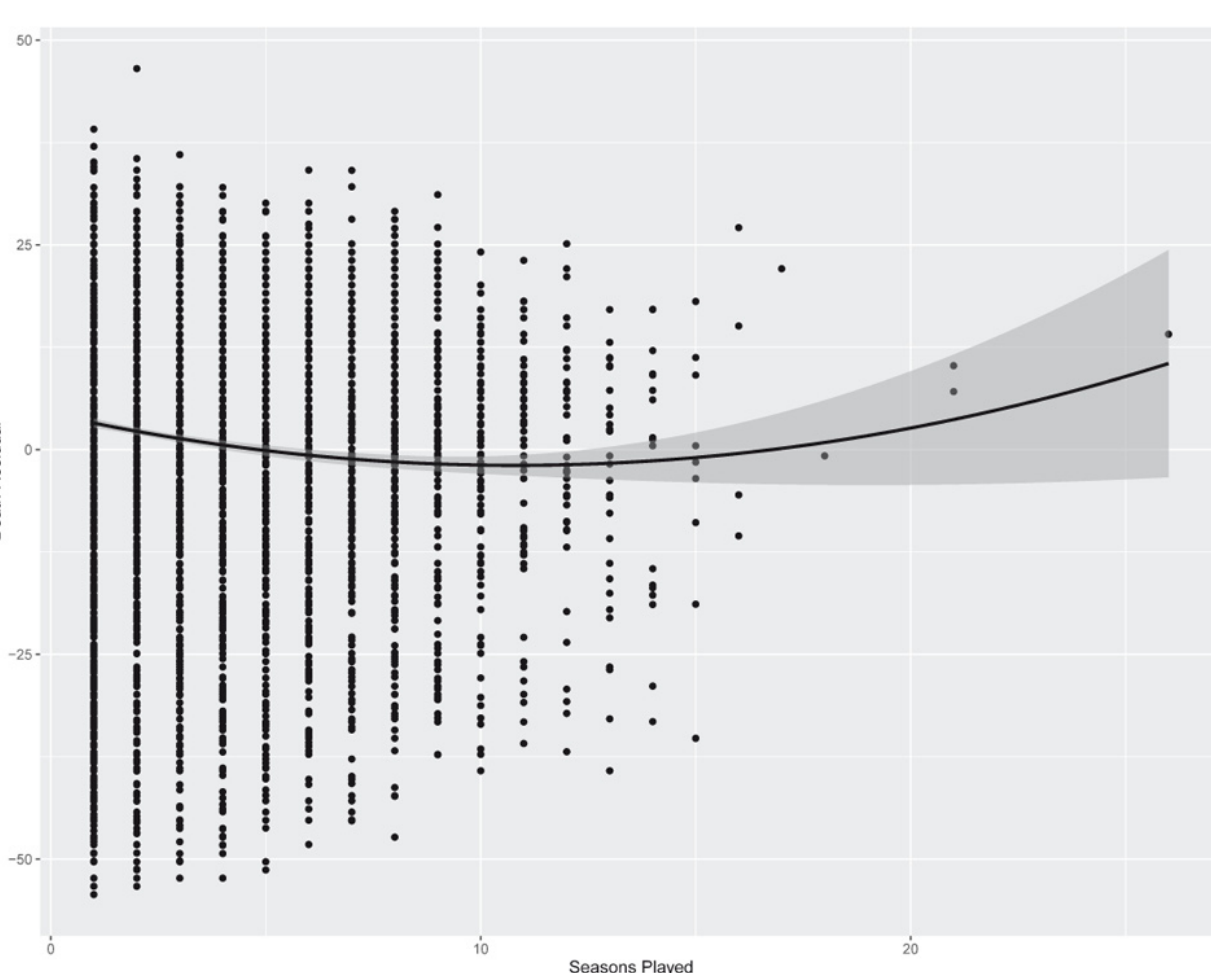
Figure 1a. Age-at-death residual versus seasons-played of deceased National Football League (NFL) players (1922–2018) N=6408. Dots represent individual players; Solid line represents a quadratic trend.